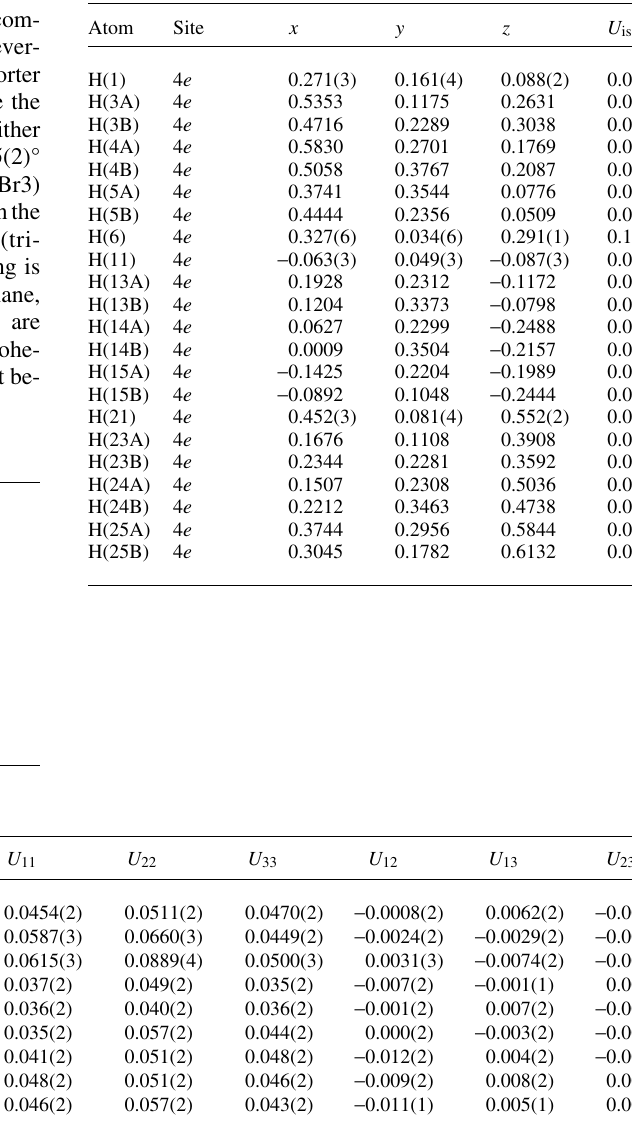
Table 2. Atomic coordinates and displacement parameters (in Å 2 ) .